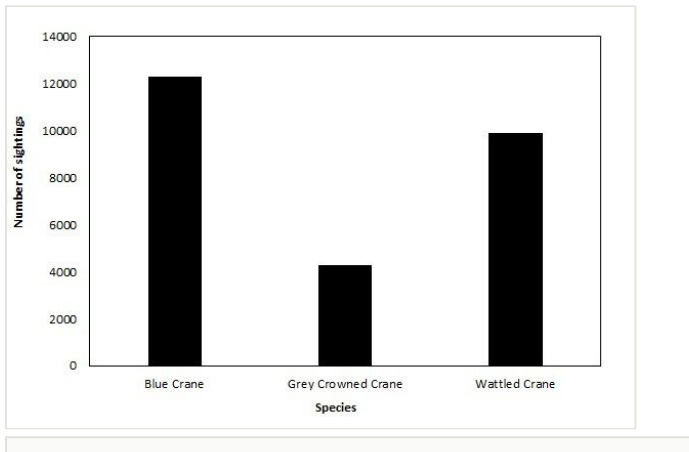
Description: General taxonomic coverage description : The dataset contains three taxa in the family Gruidae belonging to the class Aves. Species that are recorded in the dataset are: the Blue Crane Anthropoides paradiseus (46.5% of the sightings), the Grey Crowned Crane Balearica regulorum (37.5% of the sightings) and the Wattled Crane Bugeranus carunculatus (16.1% of the sightings) (Fig. 3).